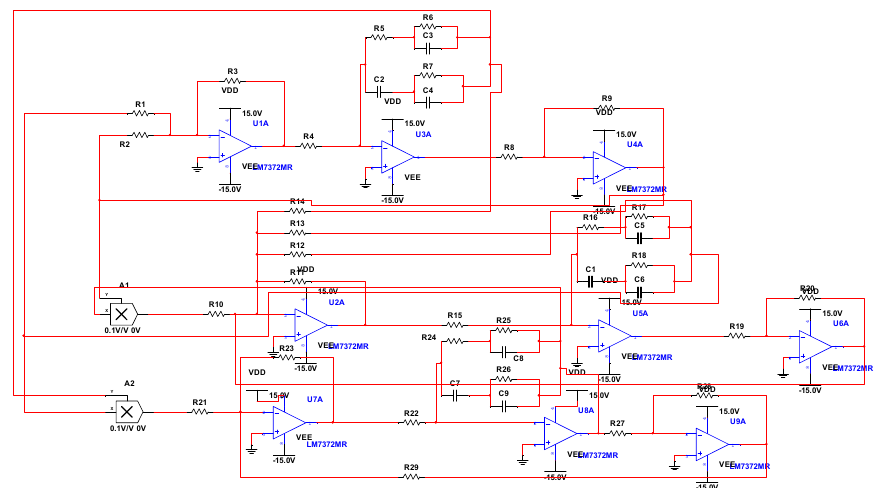
Figure 12. Fractional-order unified chaotic system circuit diagram.